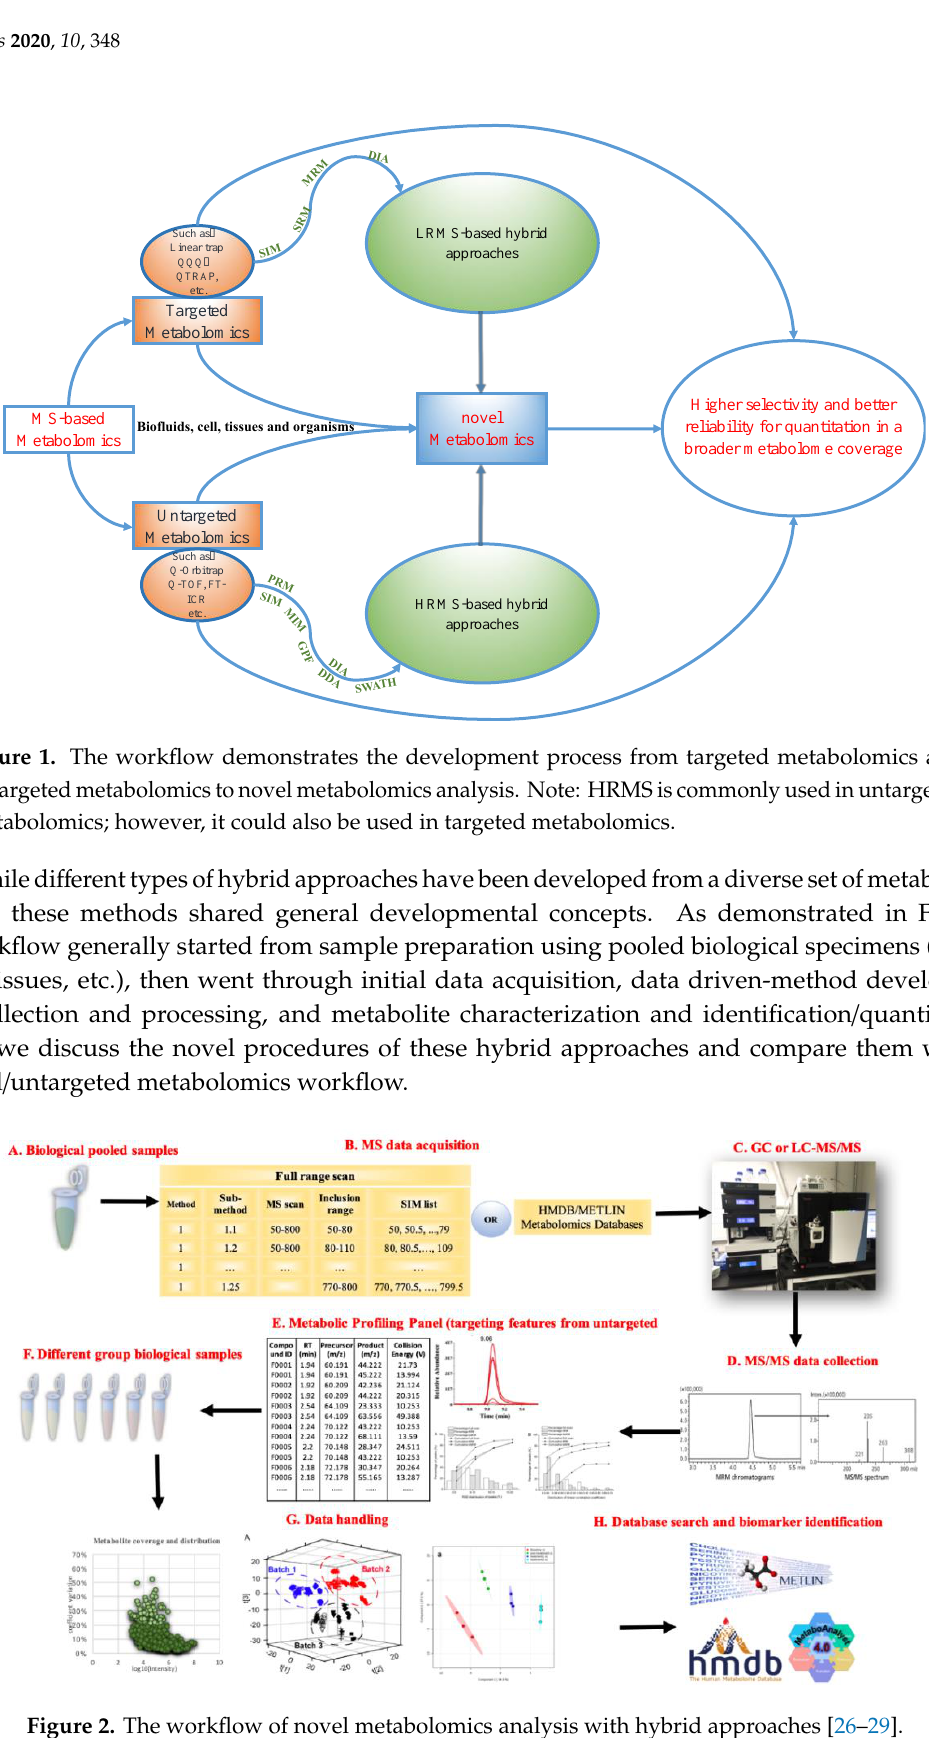
Figure 2. The workflow of novel metabolomics analysis with hybrid approaches